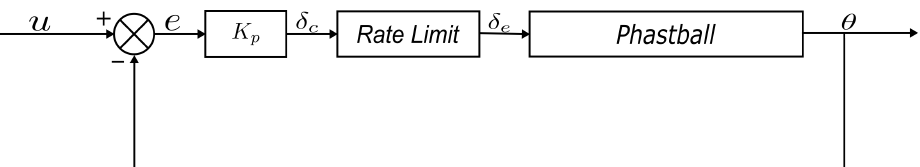
Figure 17. Closed Loop PVS system simulation used to analyze PIOs due to elevator rate